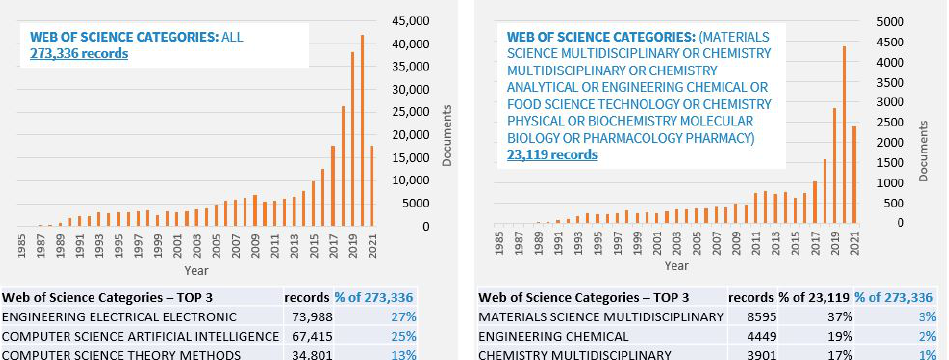
Figure 1. Evolution of the number of annually published documents (including articles, proceedings papers, reviews and book chapters), containing the following keywords in their title: “machine learning” or “artificial intelligence” or “AI” or “deep learning” or “data driven” or “neural network”. ( left ) All categories of Web of Science are included. ( right ) Only categories related to chemistry are